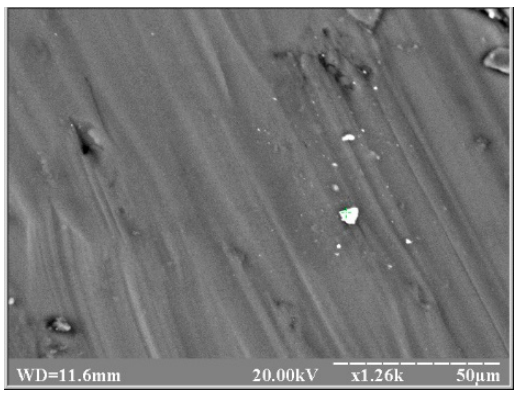
Figure 1. SEM image of surface morphology of uncoated Mg alloy.